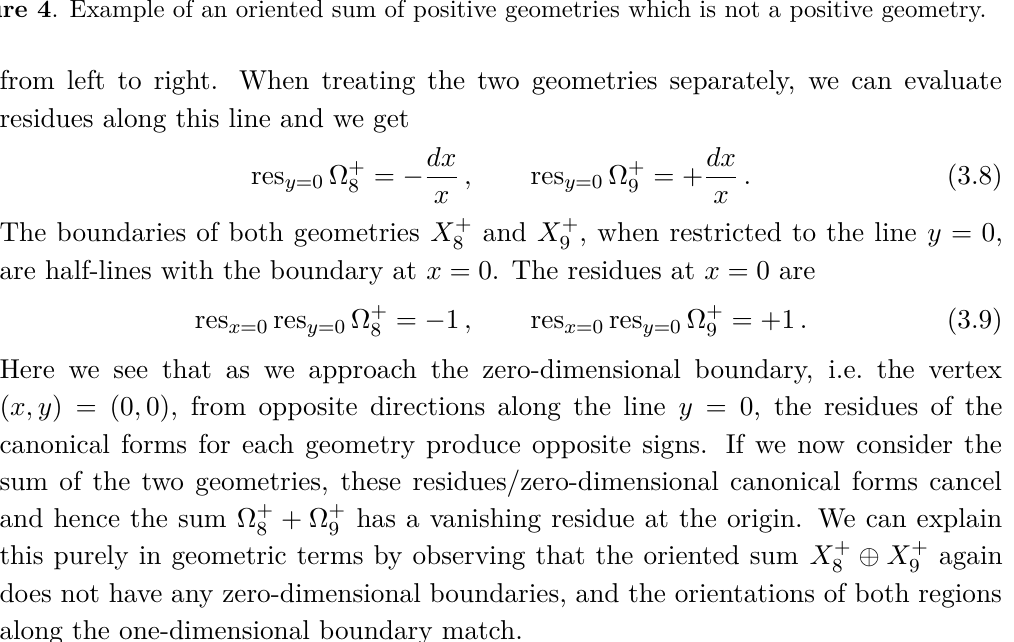
Figure 4 . Example of an oriented sum of positive geometries which is not a positive